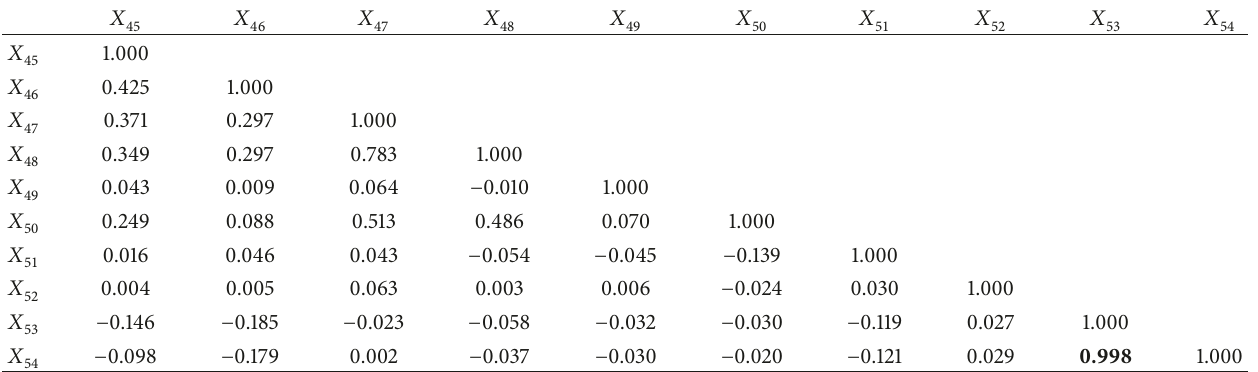
Table 3: The correlation coefficients between attributes for “ 𝐶 4 operation ability”.